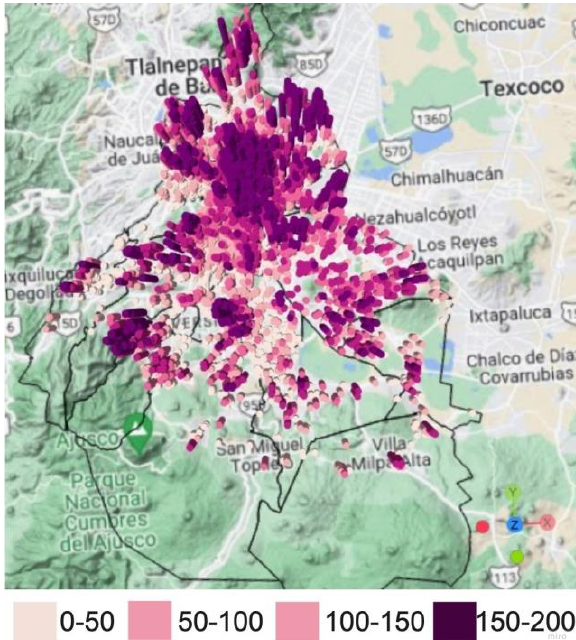
Figure 7. Hotspots of gender crimes occurring around the economic sector.